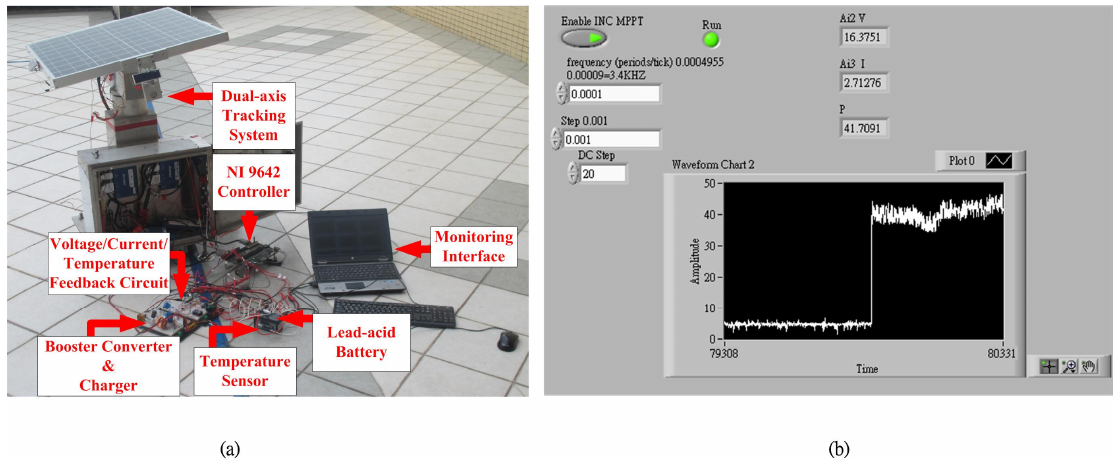
Figure 4. Solar tracking power supply system. ( a ) Onsite hardware architecture; ( b ) MPPT control interface.